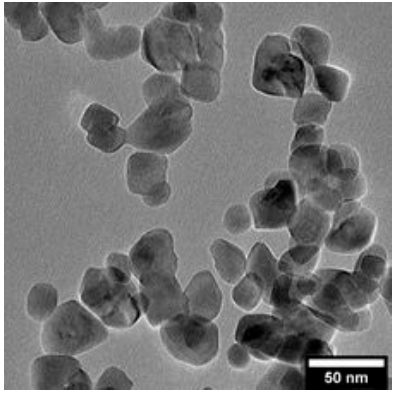
Figure 1. TEM images of LN NPs showing a pseudo-spherical shape.